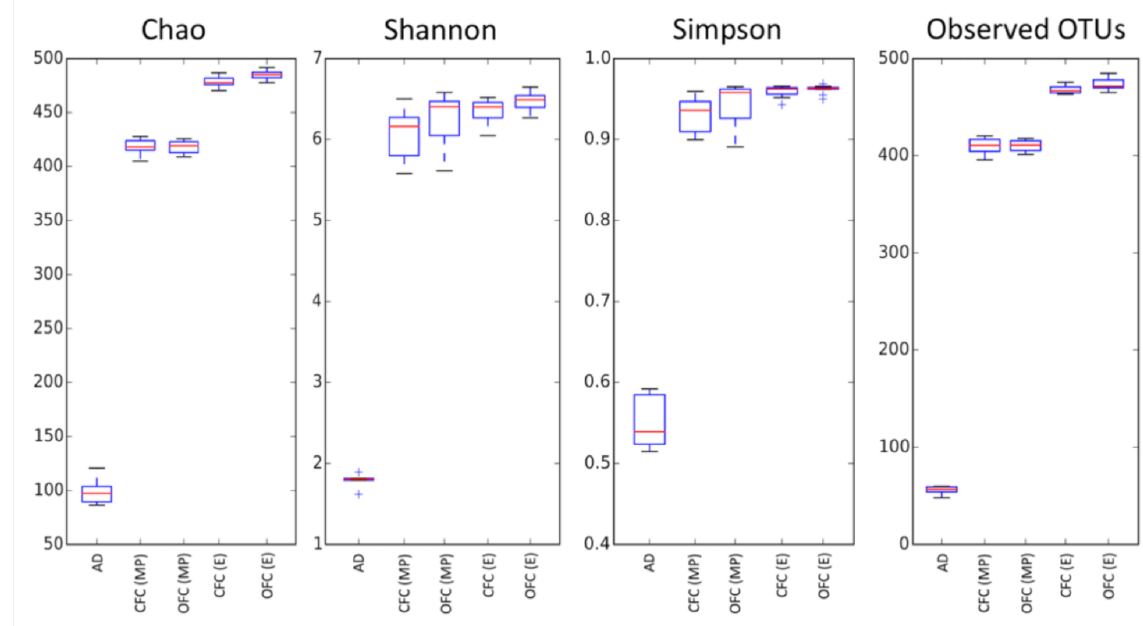
Figure 1. Evaluation of alpha diversity in commercial and optimal farm conditions by using different calculation measures: Chao 1, Shannon, Simpson, Observed Operational Taxonomic Units (OUTs). AD: arrival day; CFC (MP): commercial farm conditions at mid-period; OFC (MP): optimal farm conditions at mid-period; CFC (E): commercial farm conditions at the end of the growing period; OFC (E): optimal farm conditions at the end of the growing period.